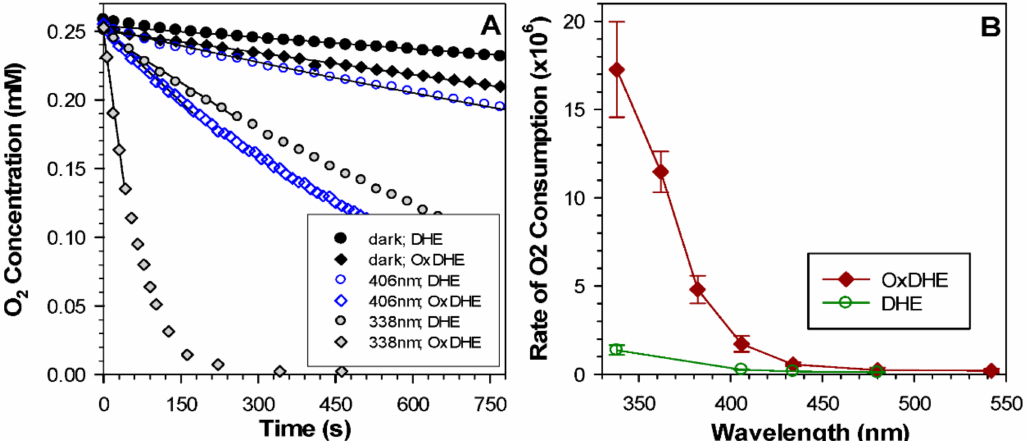
Figure 9. The susceptibility of oxidised DHE to photo-induced oxidation increases with decreasing irradiation wavelength. ( A ) Representative kinetics of oxygen consumption in the dark and during irradiation with narrow-band UV or blue light of indicated wavelengths in the suspension of liposomes made from oxidised (OxDHE) or freshly opened 16:0-22:6PC (DHE) in the presence of 0.1 mM 4-protio-3-carbamoyl-2,2,5,5-tetraperdeuteromethyl-3-pyrroline-1-yloxy (mHCTPO) used as a spin probe. ( B ) Irradiation wavelength-dependence of the initial rates of photo-induced oxygen uptake in the suspension of OxDHA and DHE liposomes normalised to the equal number of incident photons (the action